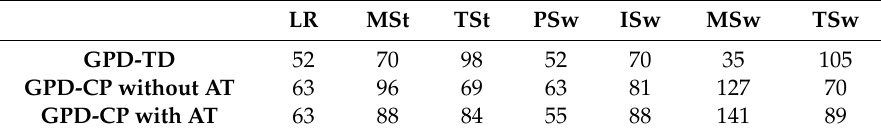
Table 3. Root mean square error (RMSE) of Gait phase detection (GPD) onset relative to motion capture (GPD-MoCap) for the typically developing version of the GPD algorithm (GPD-TD), and for the version of the GPD algorithm used for participants with CP (GPD-CP) without auto-thresholding (AT) and GPD-CP with AT. Times are in ms. Gait phases are loading response (LR), mid-stance (MSt), terminal stance (TSt), pre-swing (PSw), initial swing (ISw), mid-swing (MSw) and terminal swing (TSw). Times are in ms.